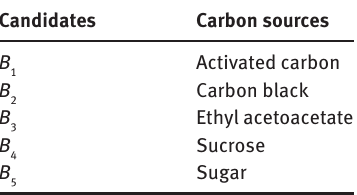
Table 6: Carbon Source Candidates for Sol–Gel.